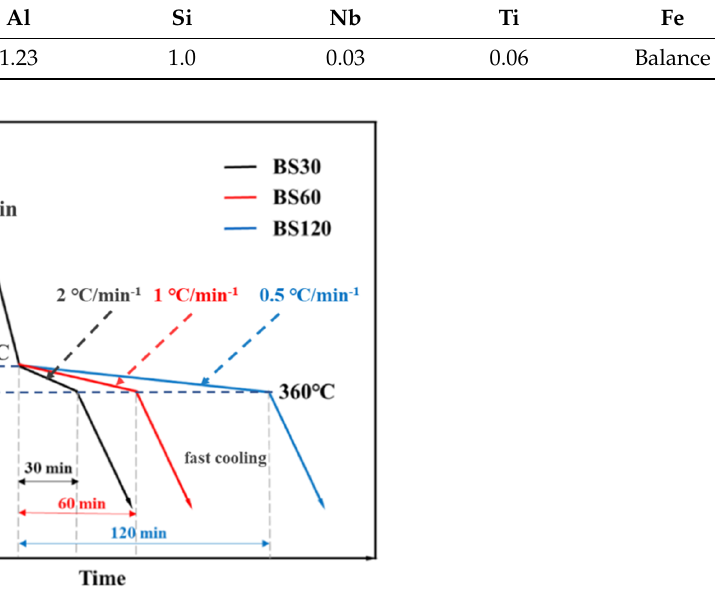
Table 1. Chemical composition of the studied steel (wt.%).